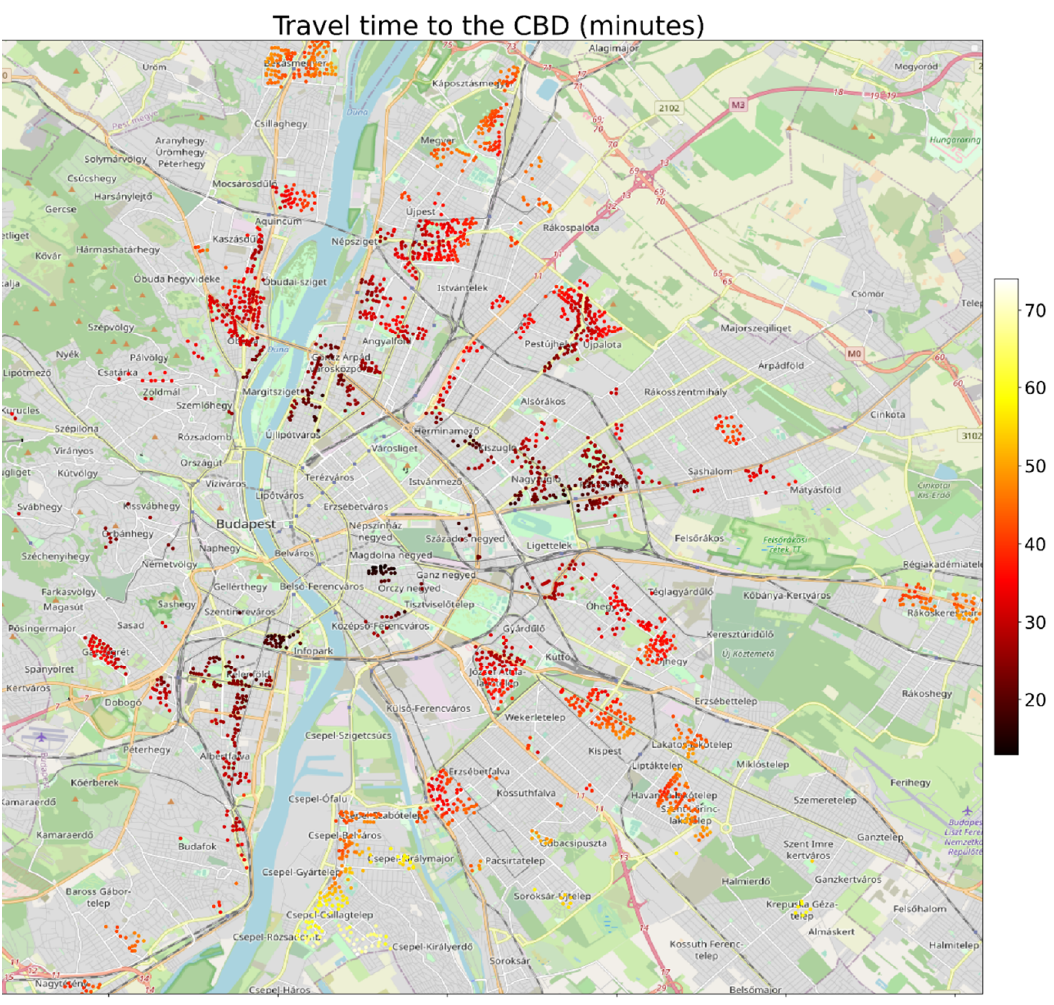
Figure A1. Travel time to the CBD from panel flats by public transport. Map data